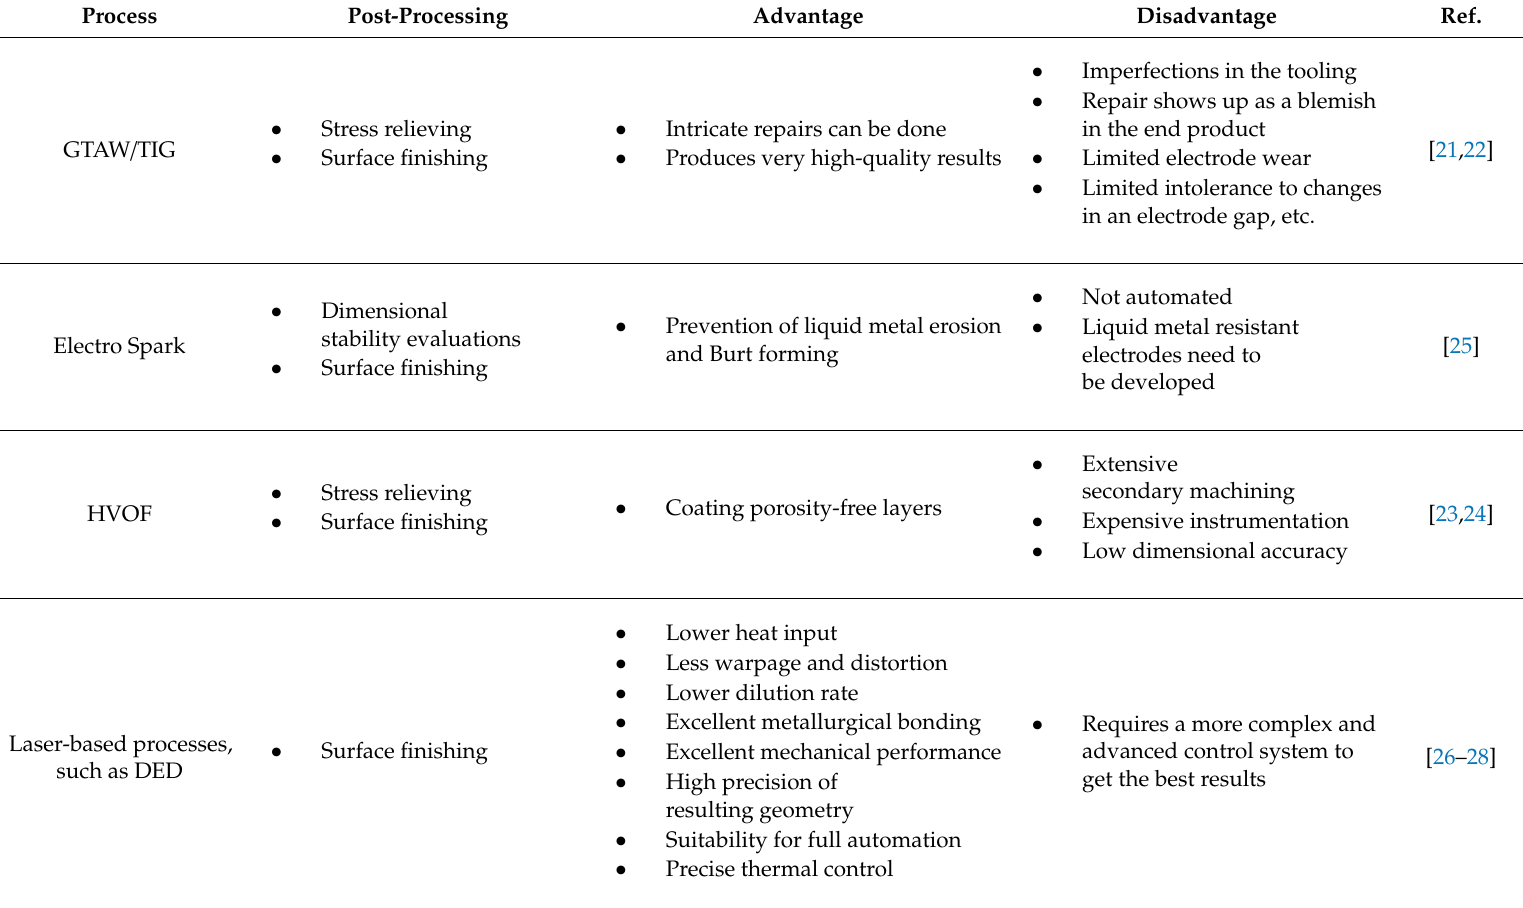
Table 1. Comparison between advantages and disadvantages of various repair and remanufacturing